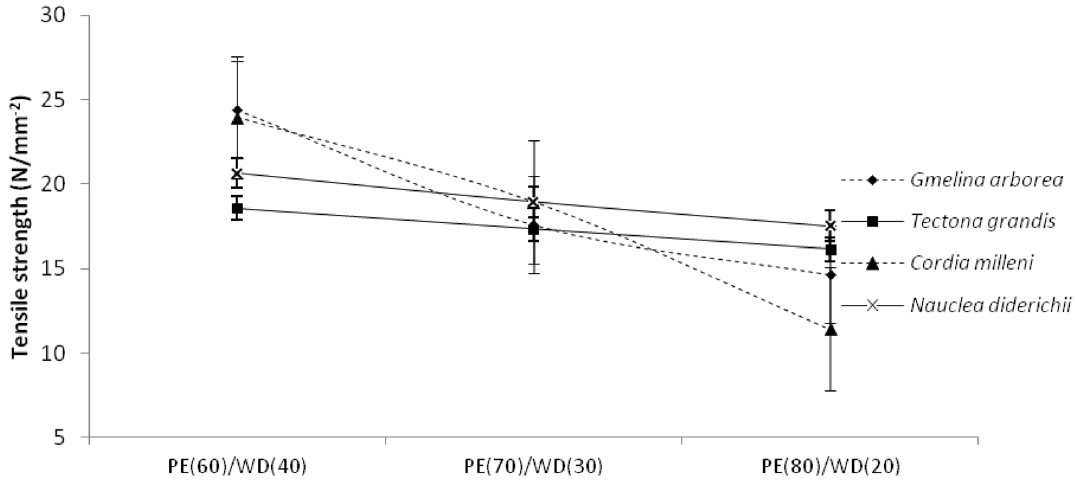
Figure 8. Tensile strength of extruded-compressed biopolymer